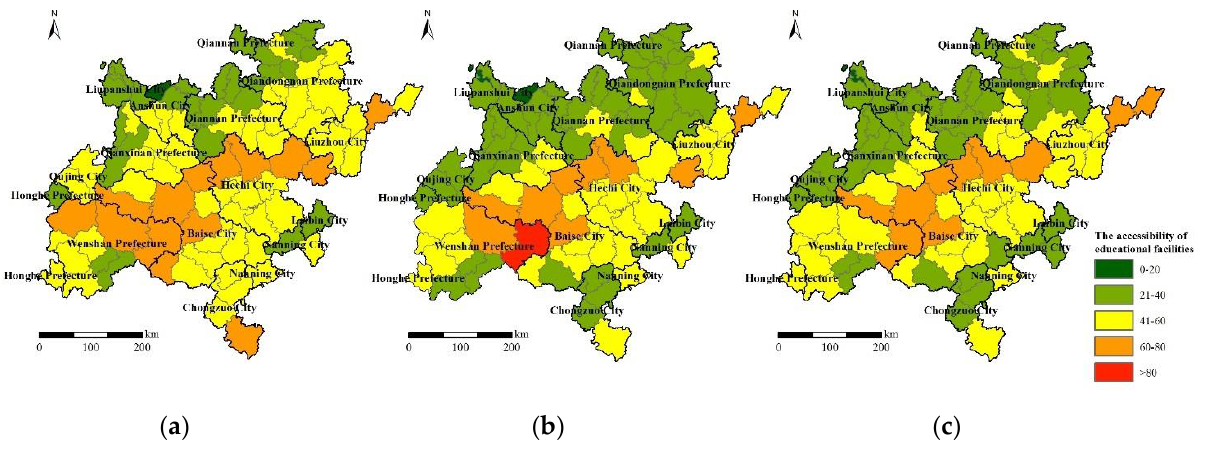
Figure 3. Evolution of accessibility pattern of educational facilities in the YGGRD, 2000 – 2019: ( a )